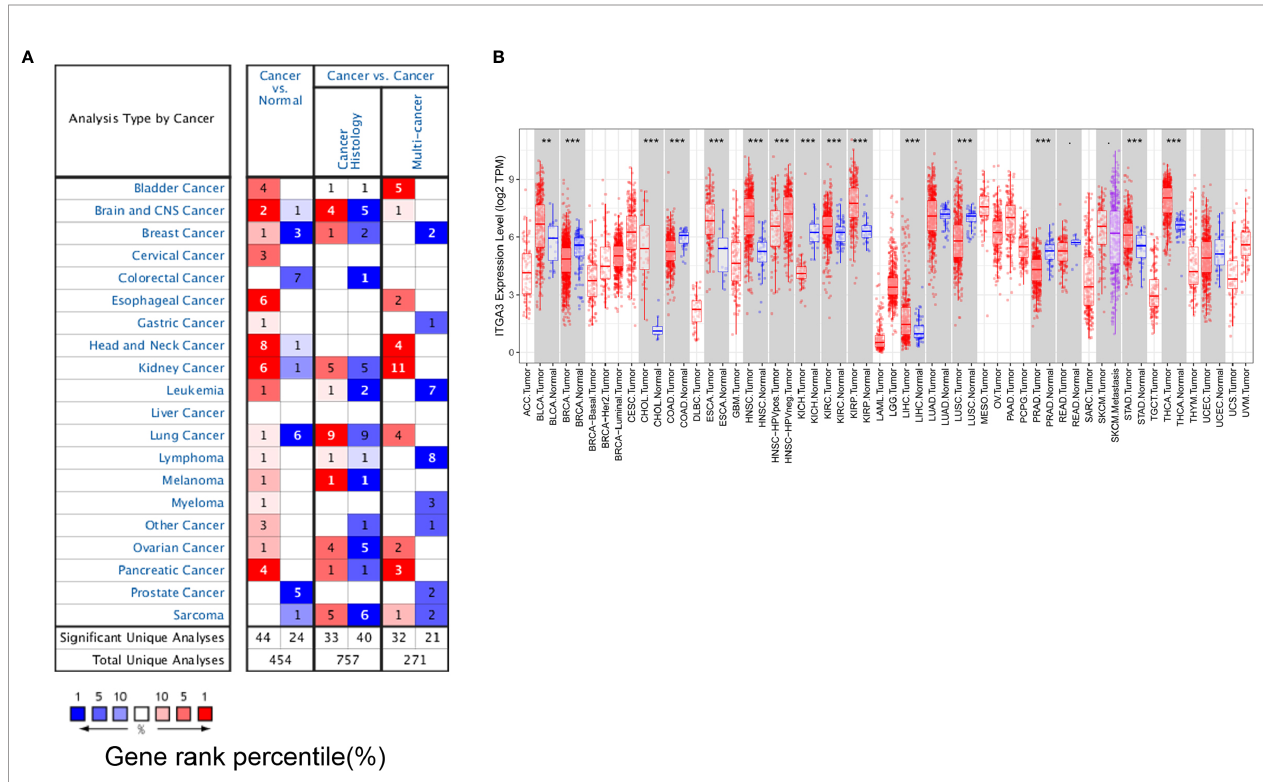
FIGURE 1 | ITGA3 transcription level in different types of tumor tissues and normal tissues. (A) The mRNA level of ITGA3 in different types of tumor tissues and normal tissues in the Oncomine database (P value is 0.001, fold change is 1.5, and gene ranking of all.). (B) The mRNA level of ITGA3 in different types of tumor tissues and normal tissues in TIMER database (P-value Signi fi cant Codes: 0 ≤ *** < 0.001 ≤ ** < 0.01 ≤ · <